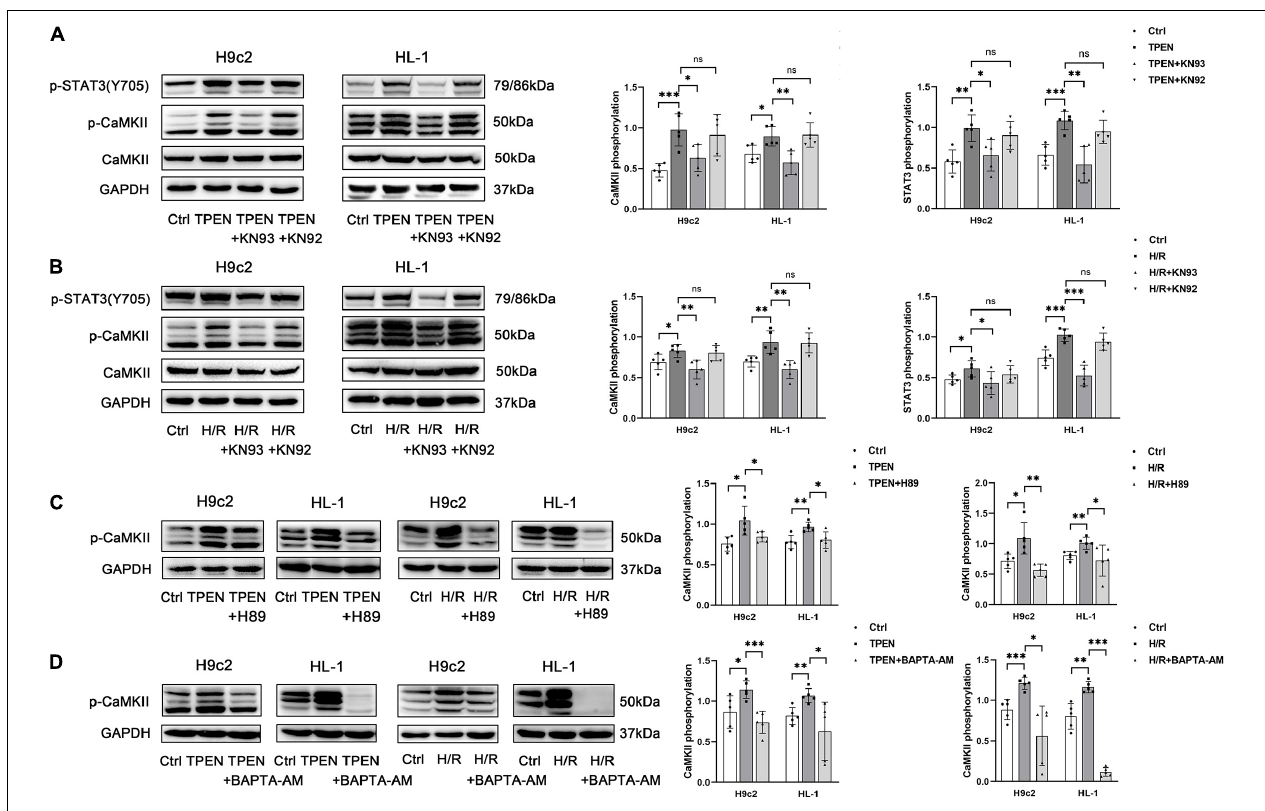
FIGURE 4 | P-CaMKII is involved in zinc deficiency-induced STAT3 activation. KN93, KN92 (A,B) , H89 (C), or BAPTA-AM (D) (10 µ M, n = 5) were applied 2 h before exposure to TPEN for 2 h or 30 min before the onset of reoxygenation. ∗ p < 0.05, ∗∗ p < 0.01, and ∗∗∗ p < 0.001. ns, no significant difference P >